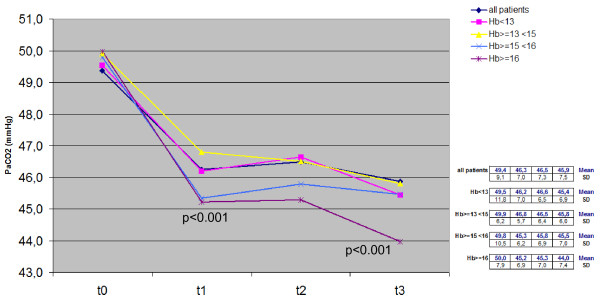
Time course of PaCO2values in the whole cohort and in each subgroup:ttest between t0and t1. Hb, hemoglobin; PaCO2, partial pressure of arterial carbon dioxide.